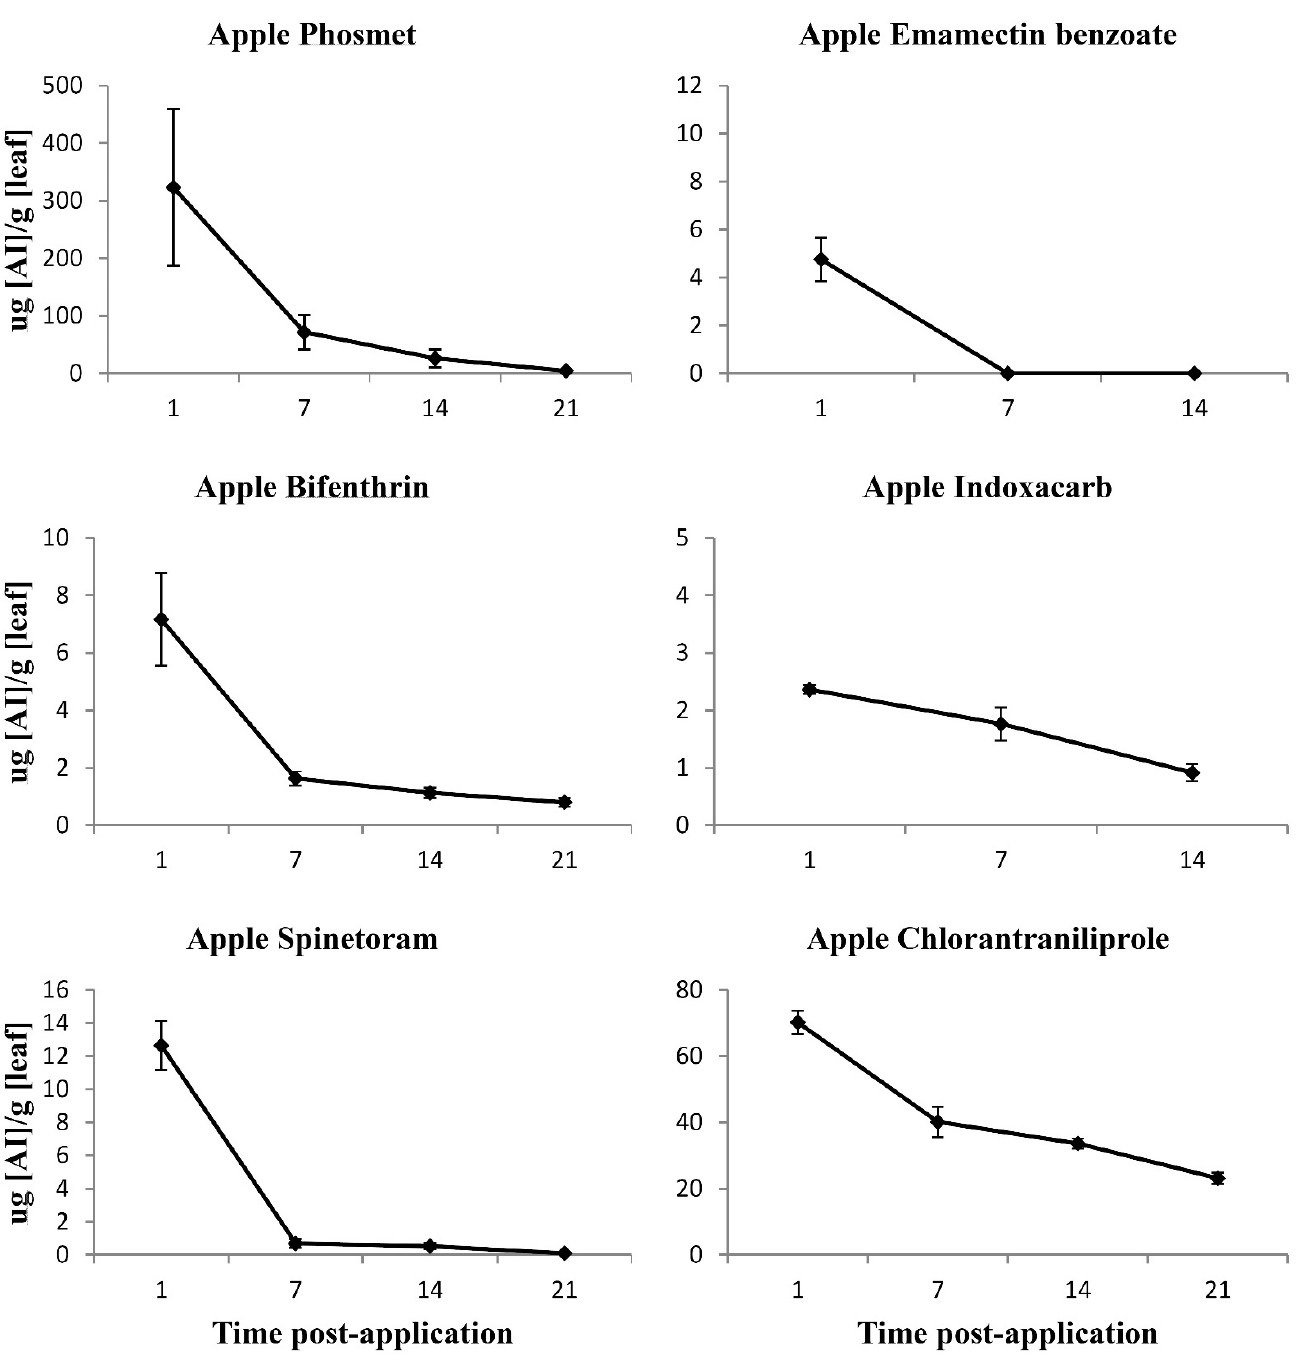
Figure 3. Residue means (SE±) measured in micrograms per gram of active ingredient per leaf taken at 1, 7, 14, and 21-day post-application.